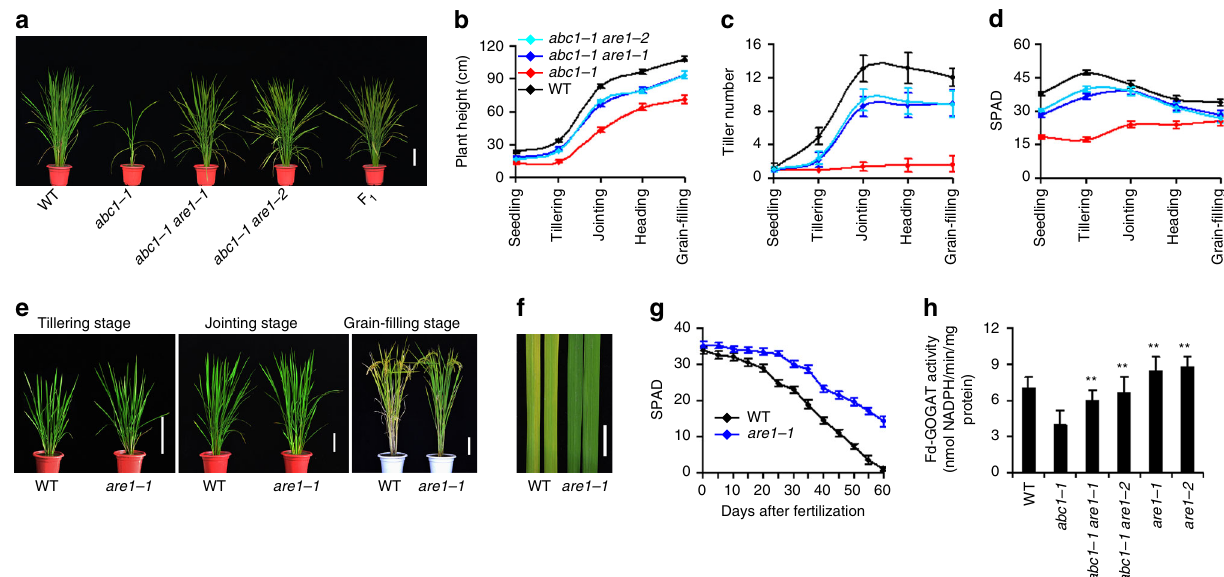
Fig. 1 Identi fi cation and characterization of the are1 mutants. a Plants at the heading stage with the indicated genotypes. F 1 refers to F 1 plants obtained from crosses between abc1-1 are1-1 and abc1-1 are1-2 . Scale bar, 15 cm. b – d Quantitative analysis of the plant height, tiller number, and soil-plant analysis development (SPAD, parameter indicating relative chlorophyll content) with the indicated genotypes at various growth stages. Data presented are mean values with s.d. ( n = 30). e Wild-type (WT) and are1-1 plants at the indicated growth stages. Scale bars, 15 cm. f Flag leaves of WT and are1-1 plants 35 days post fertilization. Scale bar, 2 cm. g Quantitative analysis of SPAD in fl ag leaves of WT and are1-1 plants at the indicated growth stages. Data presented are mean values with s.d. ( n = 40). h Analysis of Fd-GOGAT activity in leaves derived from 3-week-old seedlings with the indicated genotypes. Data presented are mean values of 4 technical repeats with s.d. ** P < 0.01 (Student ’ s t